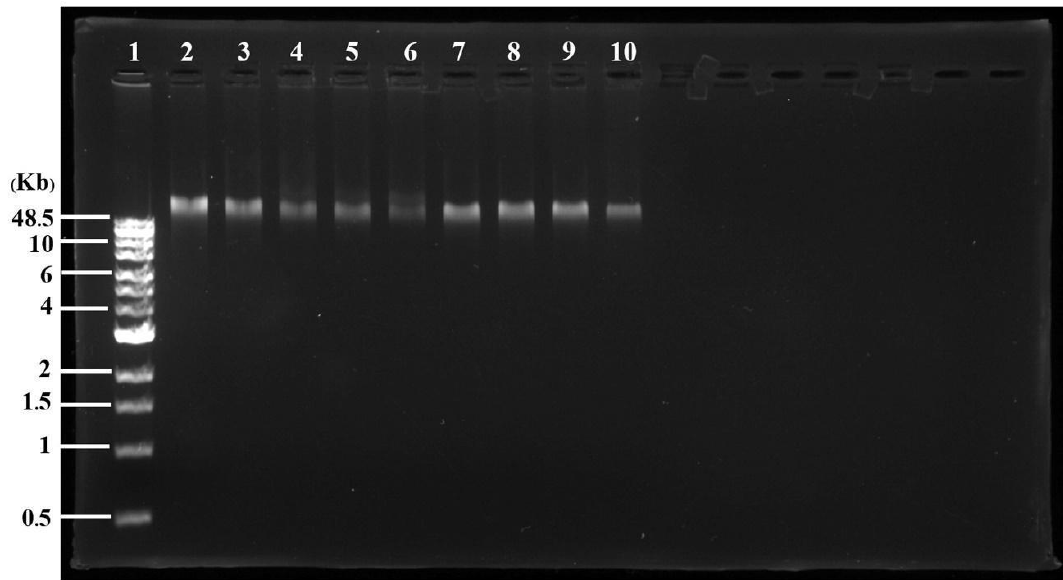
Figure 8. Agarose gel of treated and untreated bacterial genomic DNA. DNA marker (lane 1), untreated DNA (lane 2), and nanoparticles treated DNA with 4, 20, 40, and 80 µ g/mL of Col-AgNPs (lanes 3–6) and AgNPs (lanes 7–10), respectively, were shown.